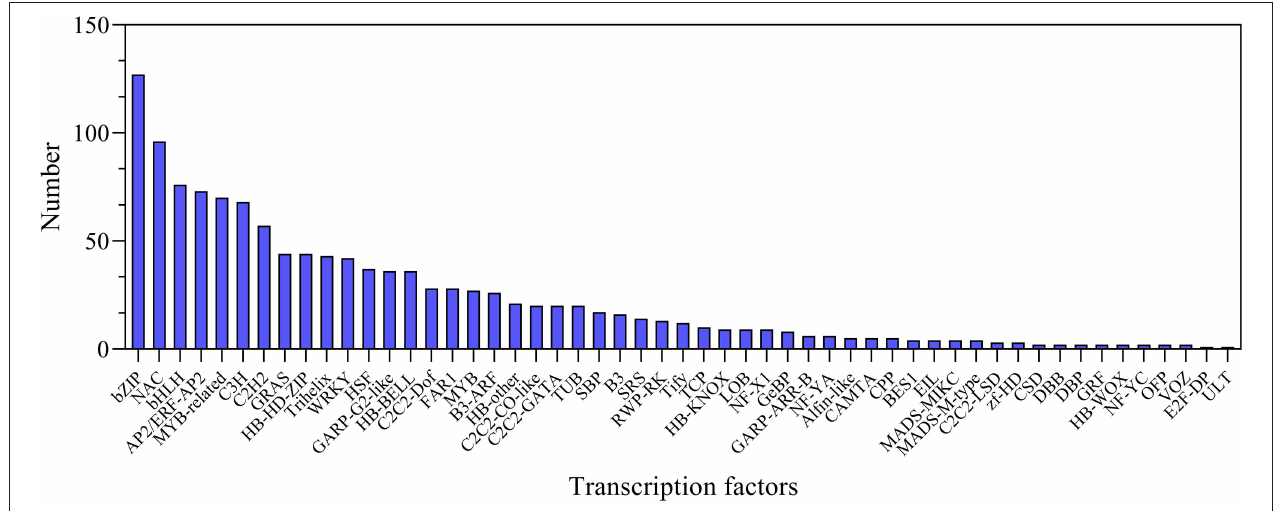
FIGURE 7 | Statistics of transcription factors under NaCl stress.